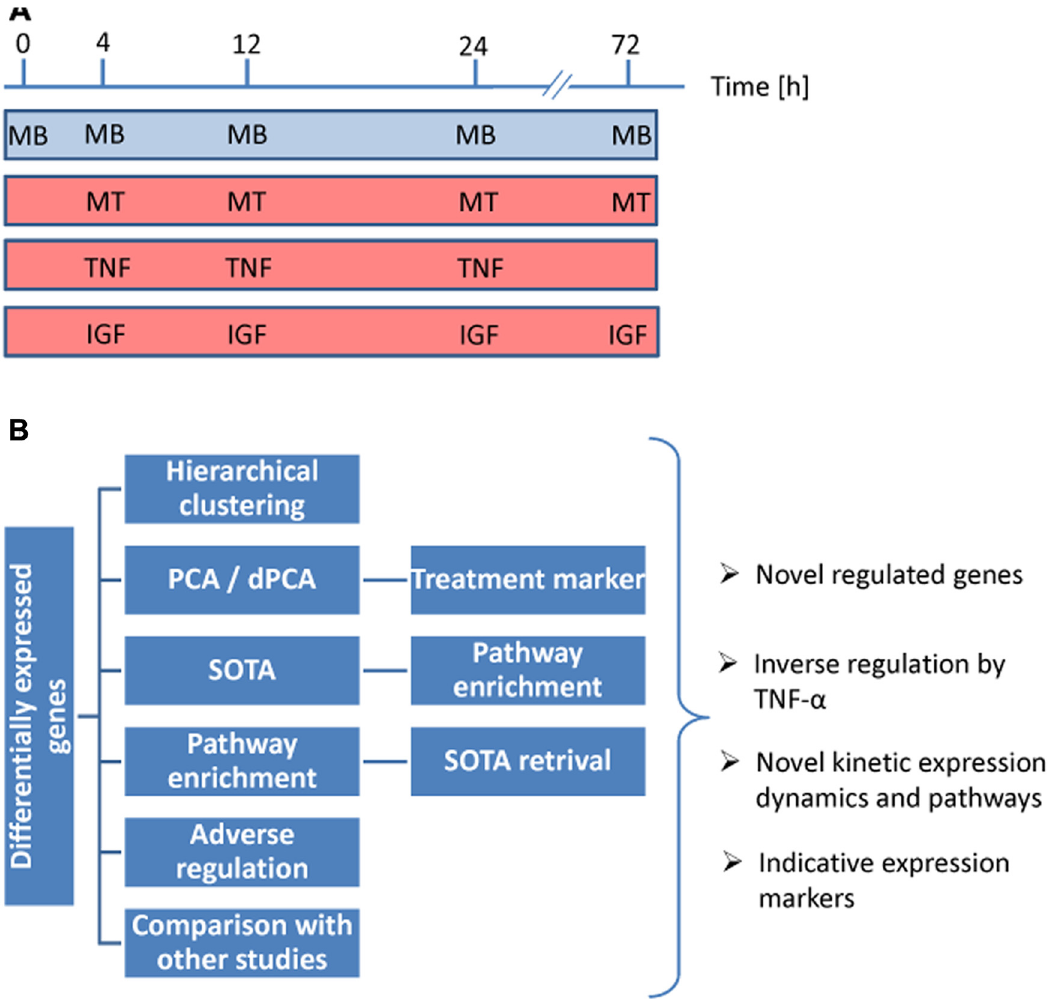
Fig 1. Experimental set up and analyses of expression profiling data. (A) Schematic overview of sampling. MB: myoblasts cultured in growth medium. MT: myotubes cultured in differentiation medium. TNF: myotubes cultured in differentiation medium with TNF- α . IGF: myotubes cultured in differentiation medium with IGF-1. (B) Gene expression data were analyzed by hierarchical clustering, principal component analysis (PCA), and dynamic PCA among others. Moreover, the profiling data were clustered by applying the self-organized tree algorithm (SOTA) as well as pathway association enrichment analyses. Furthermore, genes adversely regulated by differentiation and TNF- α were identified. Finally, TNF- α -regulated genes were compared with results of other studies. The study identified novel insights into the gene expression mechanisms and kinetics of early skeletal myocyte differentiation and how this is modified by TNF- α